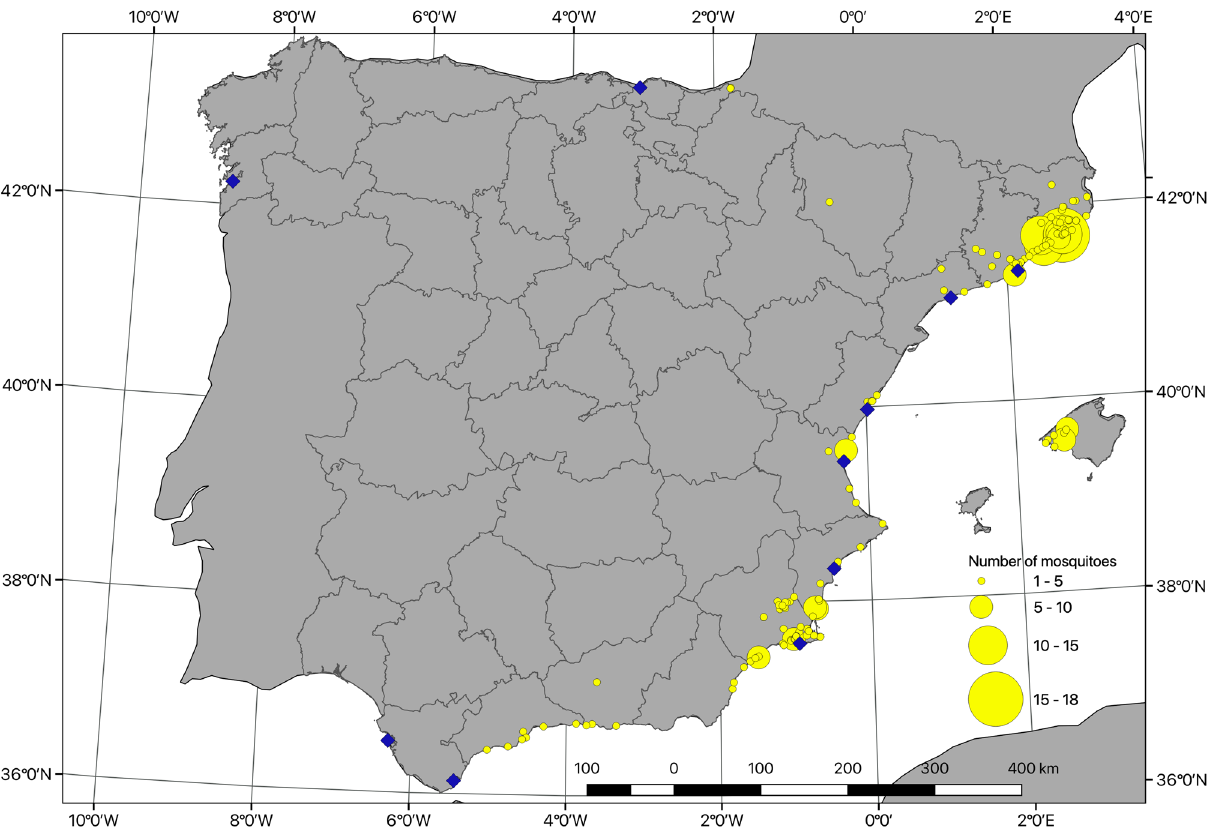
Figure 1. Locations sampled for genetic analysis. Yellow circles are centered on sample locations with radius proportional to number of mosquitoes sampled at each location. Blue diamonds indicate locations of major commercial ports in Spain (ports with over 50,000 TEU -Twenty-Foot Equivalent Unit-, based on AAPA -American Association of Port Authorities- data from 2013). Grey lines indicate provinces of Spain. Land boundaries from Natural Earth. Province boundaries from GADM.